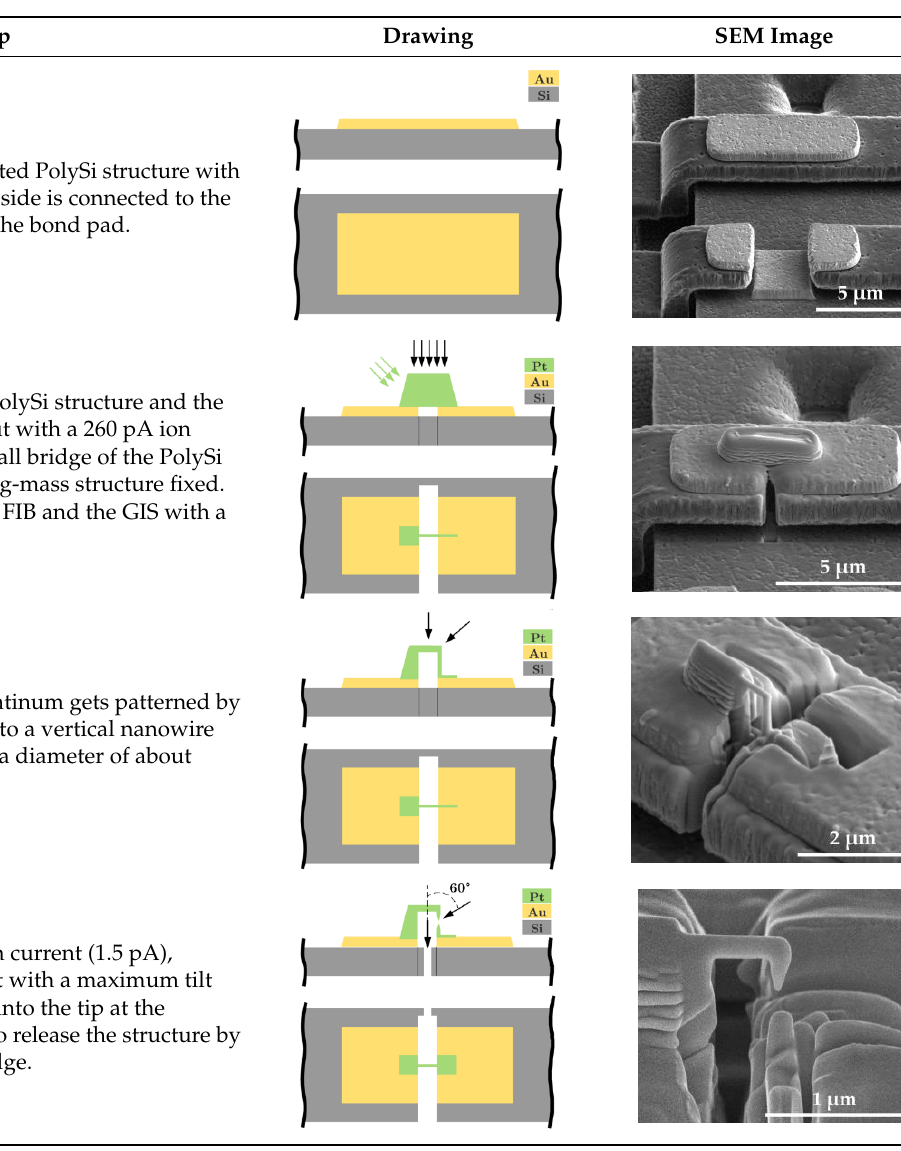
Table 5. Process steps of fabrication method of small tunneling tips by FIB and GIS.